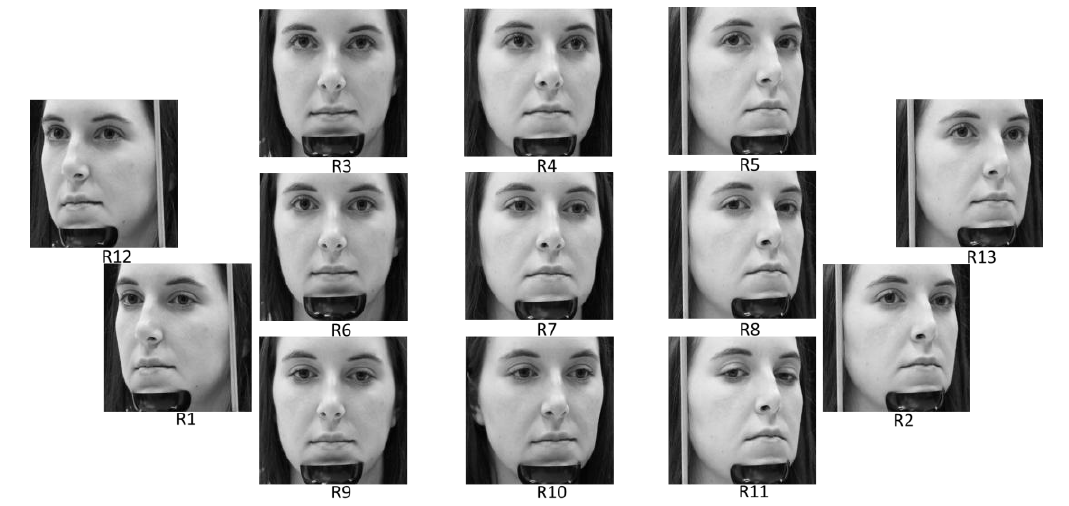
Figure 15. Eye gaze and head pose images selected from CAVE-DB.